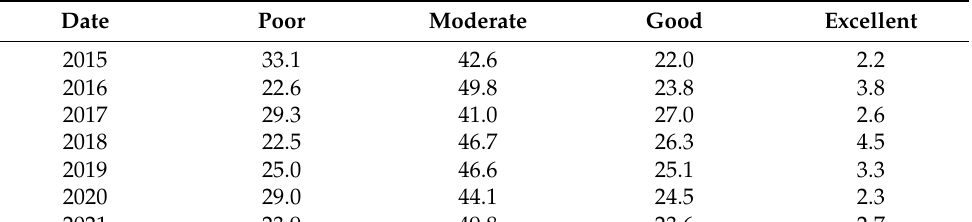
Table 5. Proportion of RSEI area at different levels in the mainstream area of the Tarim River from 2015 to 2021 (unit: %).